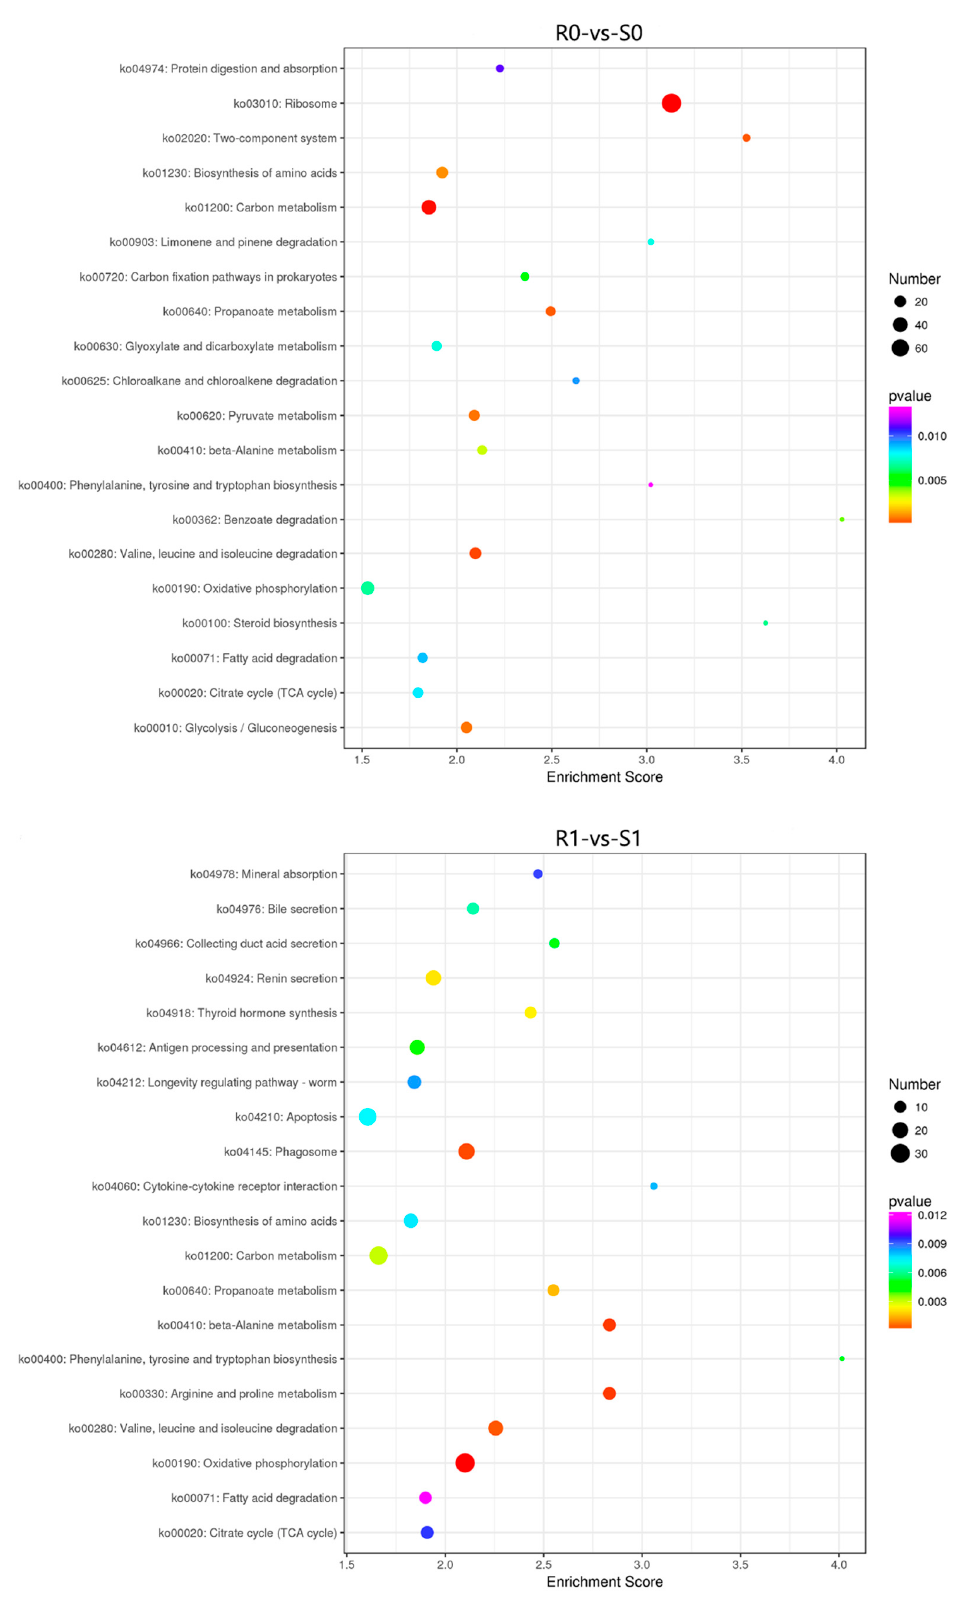
Figure 7. Scatterplot of the top 20 most enriched KEGG enrichment pathways for the DEGs in the four comparison groups. The X -axis indicates enrichment score, and the Y -axis represents the distinct KEGG pathways.